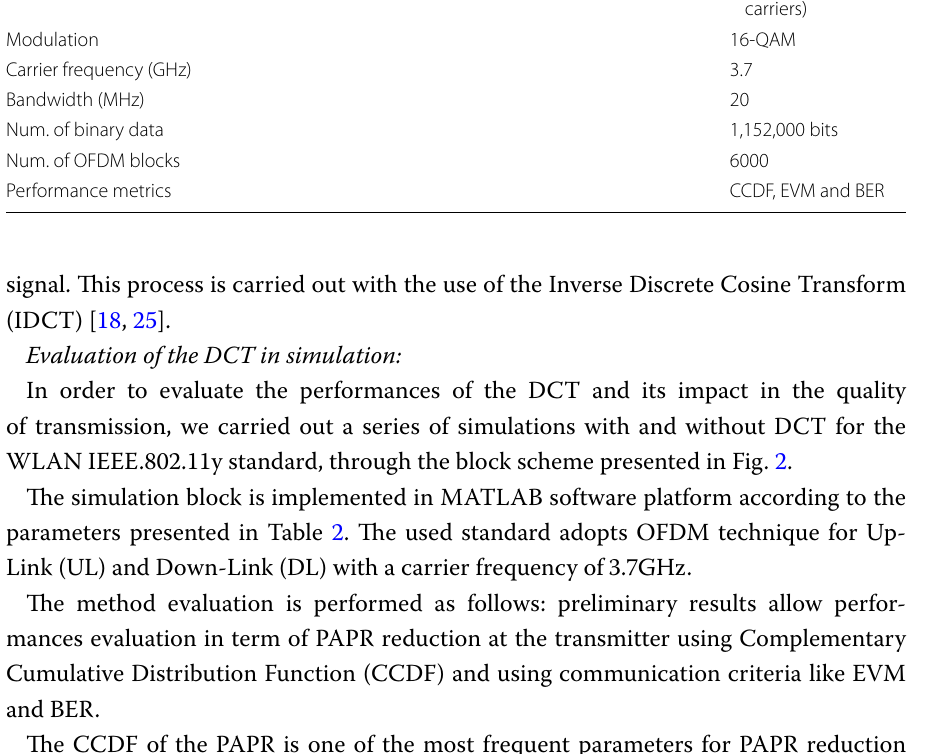
Table 2 Simulation parameters Parameter Num. of